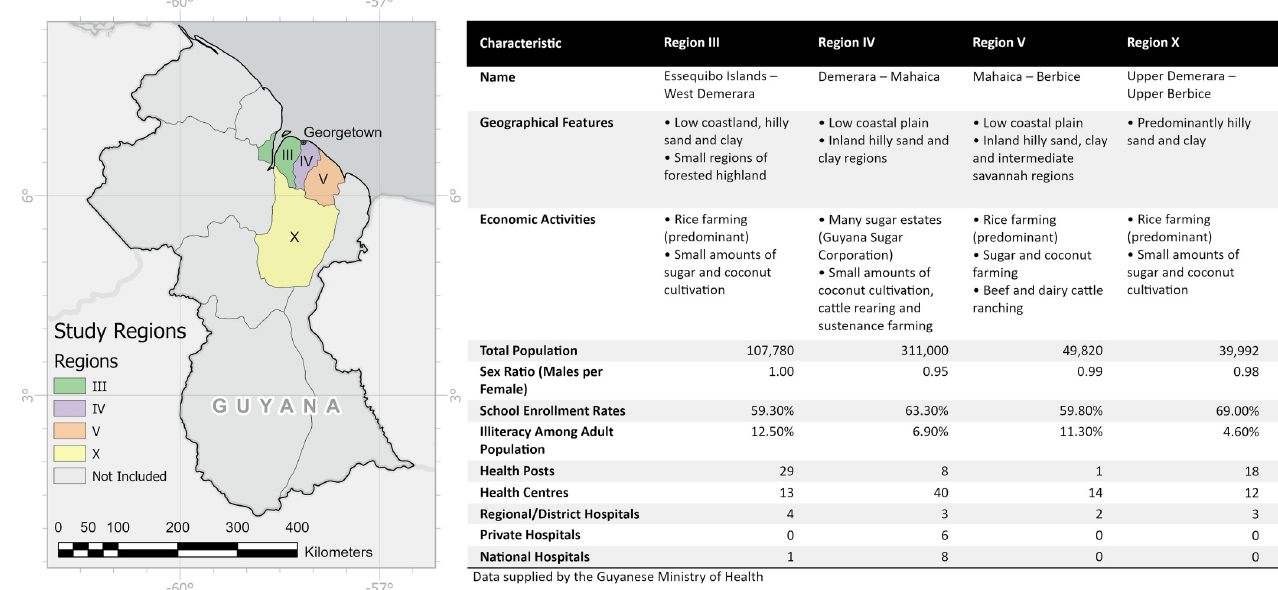
Fig 1. Description of study regions. Map content was produced with Esri ArcGIS software using data provided by Natural Earth (2018). [digital geospatial data]. Available online: https://www.naturalearthdata.com/ [17/08/2021].